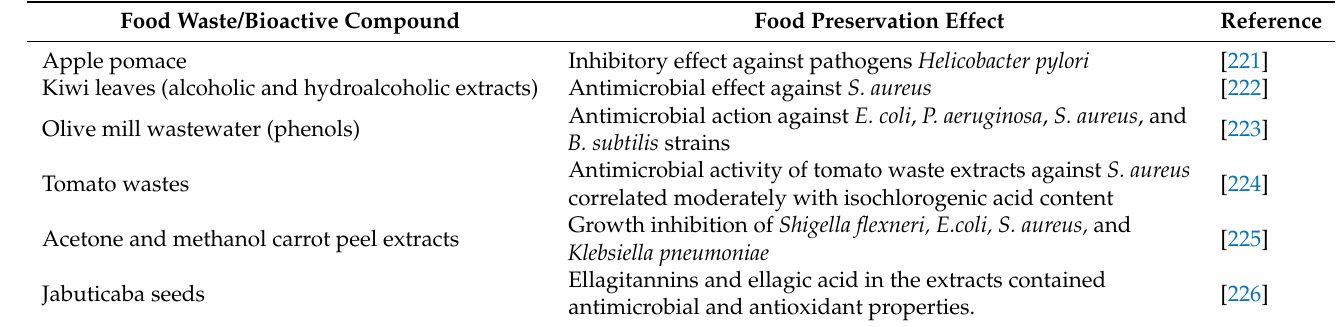
Table 4. Bioactive compounds extracted from fruit waste and their application as a natural food